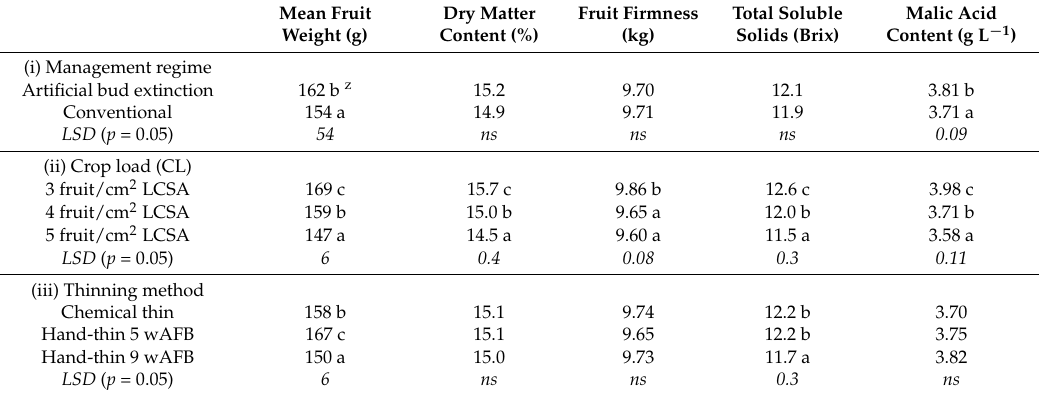
Table 7. Effect of training regime, crop load and thinning method on apple fruit quality of ‘Royal Gala’ (Trial 1). LCSA = limb cross-sectional area; wAFB = weeks after full bloom. Mean Fruit Weight